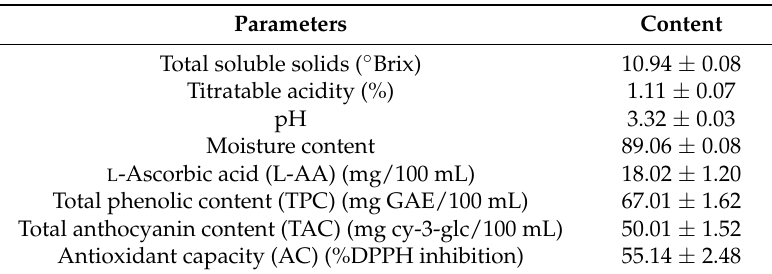
Table 1. The initial quality parameters of the raw